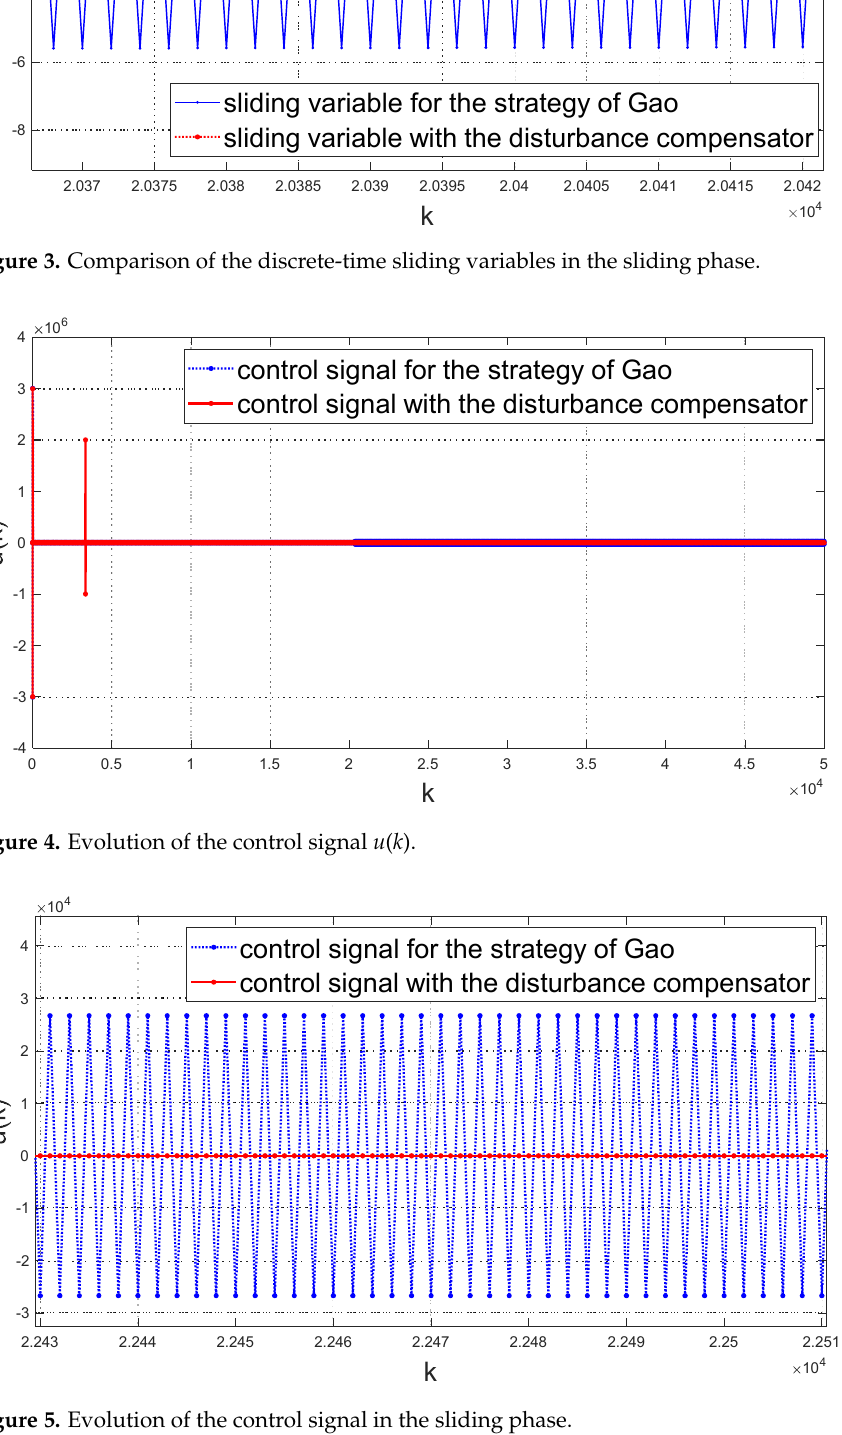
Figure 5. Evolution of the control signal in the sliding phase.